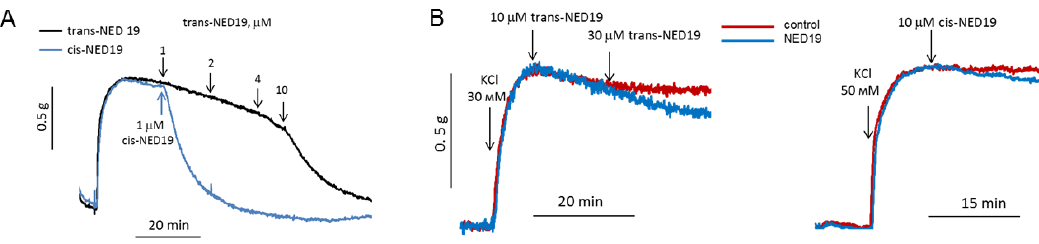
Figure 7. The influence of cis - and trans -NED19 on the contraction of aortic rings preconstricted